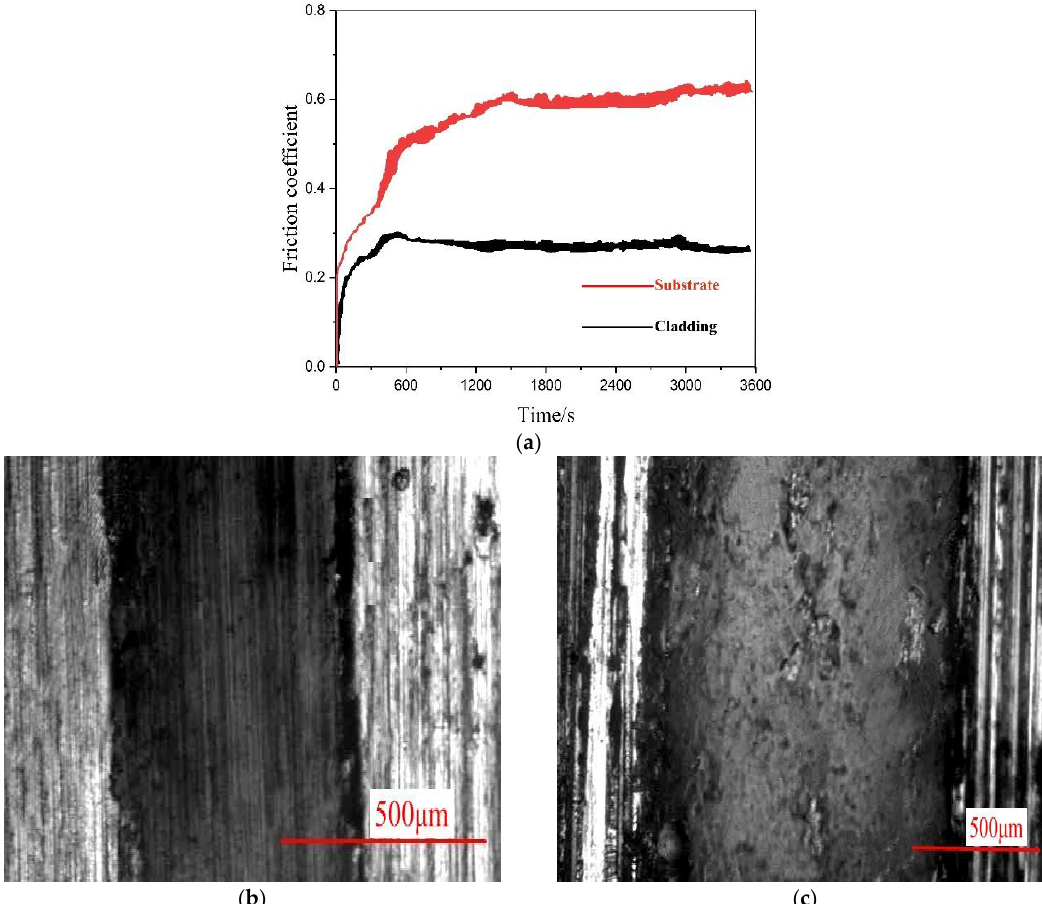
Figure 15. ( a ) Friction coefficient curve of the cladding layer and substrate. ( b ) Wear morphology of the cladding layer made with optimized parameters. ( c ) Wear morphology of the substrate without a cladding layer.